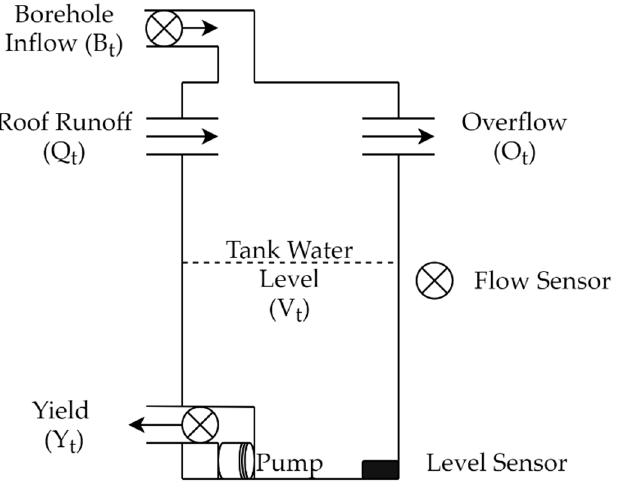
Figure 1. Schematic of the rainwater harvesting (RWH) system.